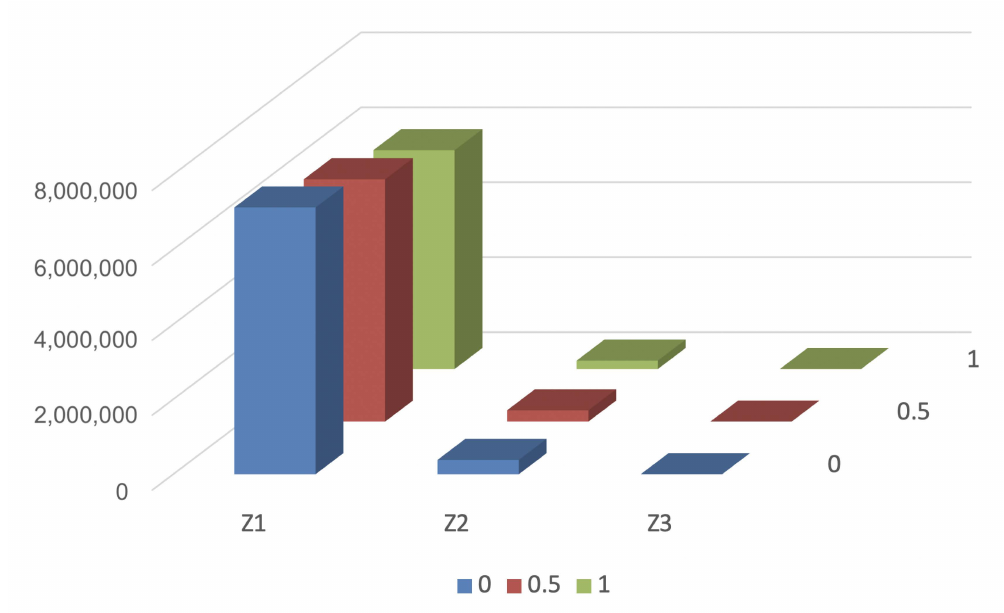
Figure 1. Value of objective